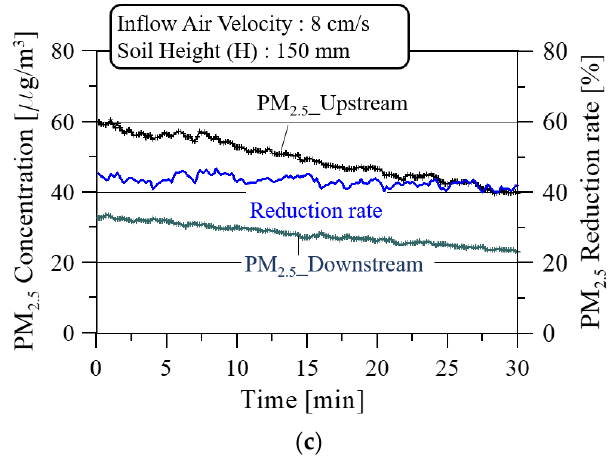
Figure 8. PM 2.5 concentrations and reduction rate at the soil height (H) of 150 mm and the soil moisture of 15 ± 5% for three inflow air velocities: ( a ) 2 cm/s; ( b ) 5 cm/s; and ( c ) 8 cm/s. As shown in Figure 9, the average PM 2.5 reduction rate decreased from 48.7% to 43.2% real-time PM 2.5 reduction rate increased from 4.7% to 8.5%, based on the average value, as of freedom between soil grains as the velocity increases.